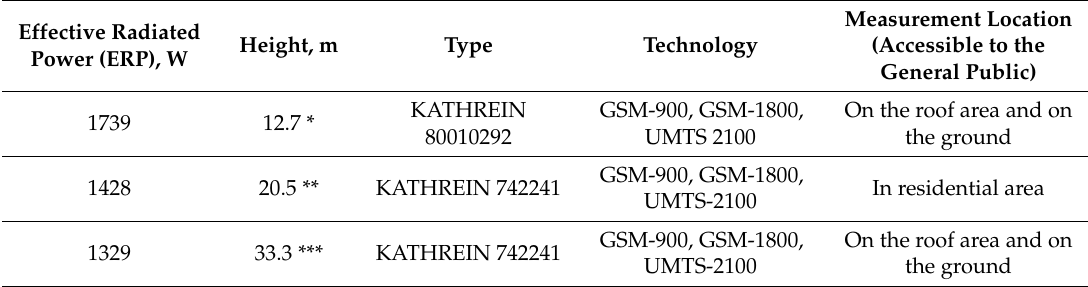
Table 1. Antenna technical